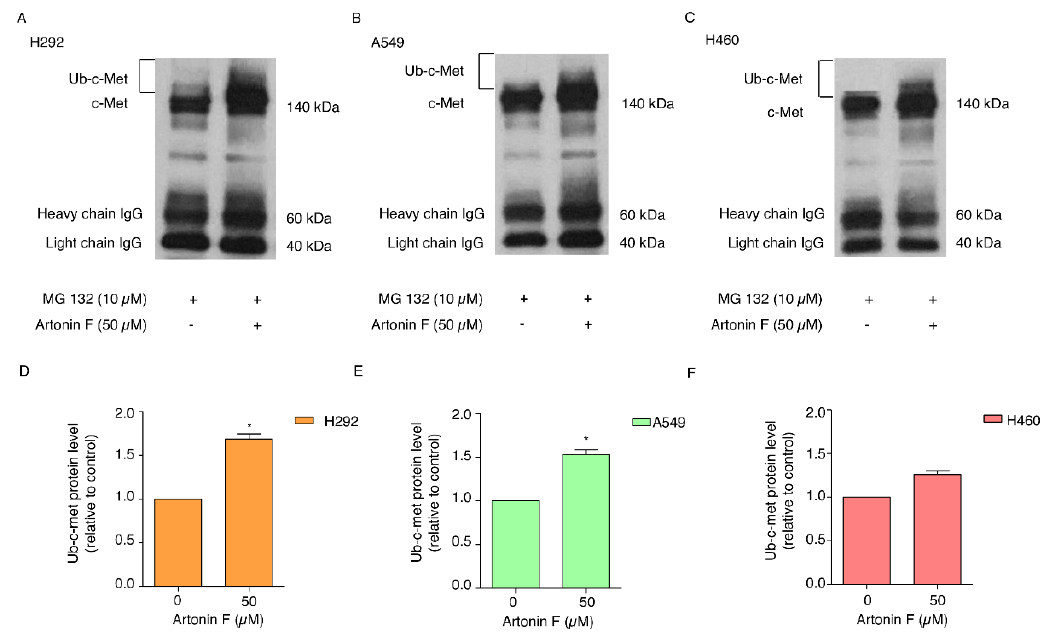
Figure 5. Artonin F induces ubiquitin-mediated c-Met proteasomal degradation. ( A – F ) Human cancer cells were pretreated with MG132 10 mM for 30 min, followed by treatment with artonin F 50 μ M for 5 h. The protein lysates were collected and incubated with a mixture of beads and c-Met primary antibodies to pull out the protein of interest. Cell lysates are subjected to IP anti-c-Met and the immunoprecipitation complexes were analyzed for ubiquitin levels by Western blotting. The relative protein levels were calculated by densitometry. Data are shown as the mean ± SEM ( n = 3). * p < 0.05 versus the non-treated control.